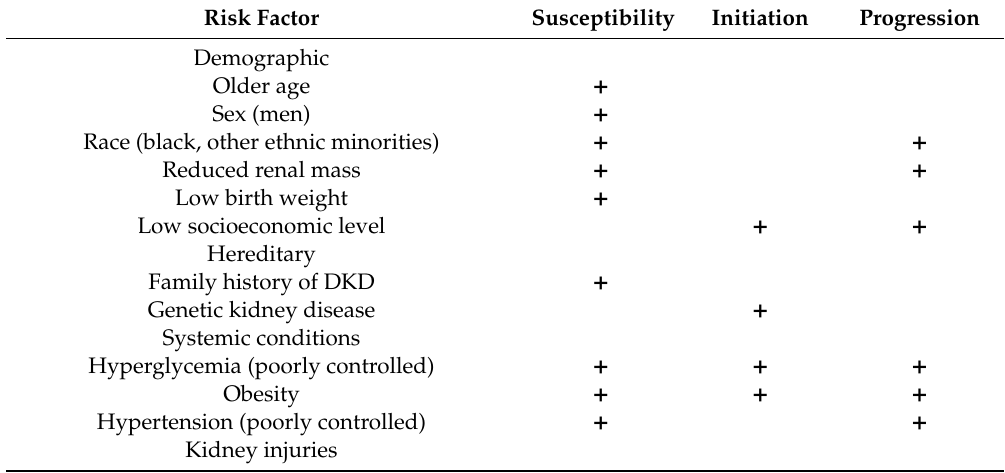
Table 1. Risk factors for diabetic kidney